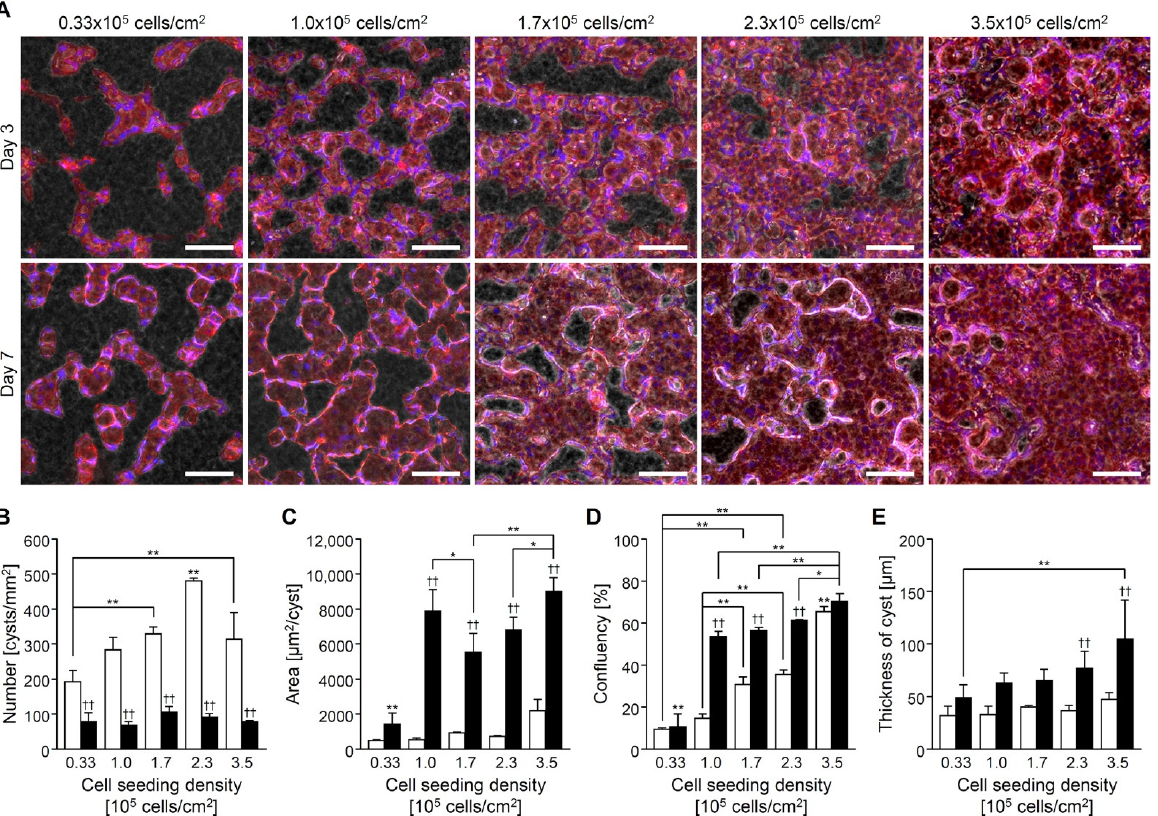
Figure 3. CHK-Q cell cyst characteristics with collagen gel sandwich culture system at several cell density conditions. ( A ) Merged images of phase-contrast and fluorescent micrographs. Red (rhodamine phalloidin): F-actin. Bars represent 100 µ m. ( B ) Number, ( C ) area, ( D ) confluence, and ( E ) cyst thickness ( n ≥ 3). Open and closed columns represent 3 and 7 days of culture, respectively. Data presented as the mean ± SD, ** p < 0.01 and * p < 0.05 (compared with culture conditions within the same culture time), and †† p < 0.01 (compared within the culture time under the same culture conditions) (two-way analyses of